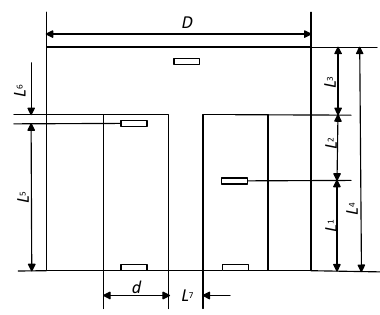
Figure 4. Main dimension of transducer elements.